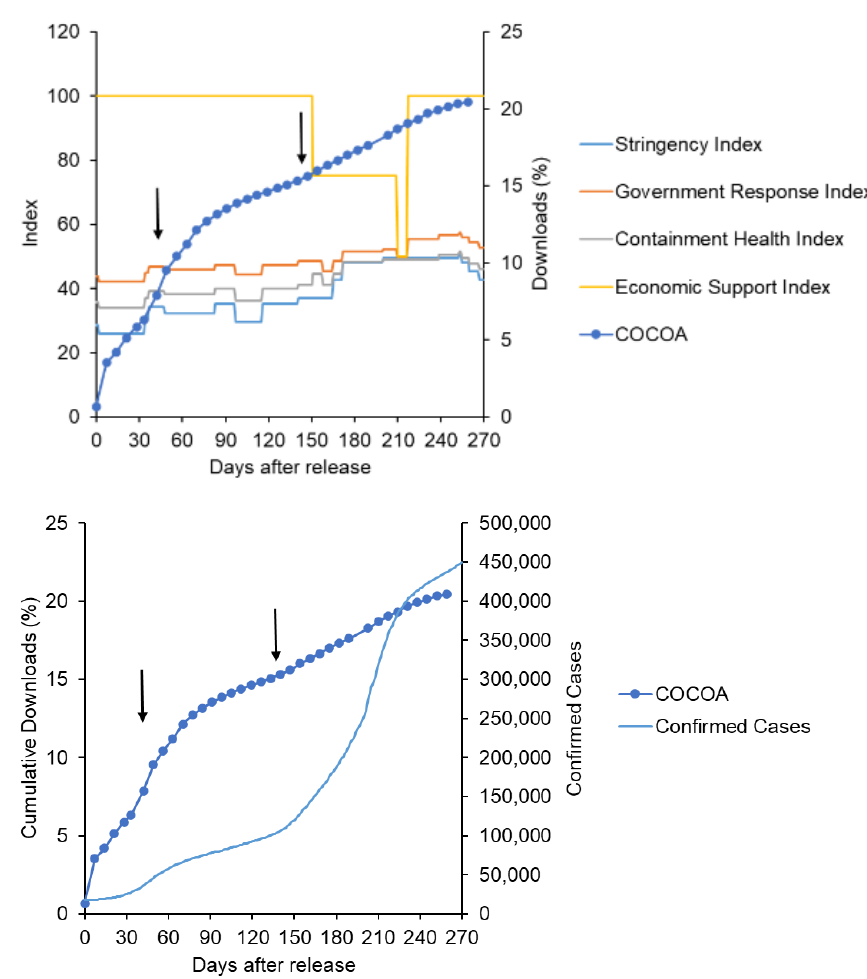
Figure 7. Relationship between the number of COCOA downloads and government interventions (upper panel) and the number of positive cases (lower panel).